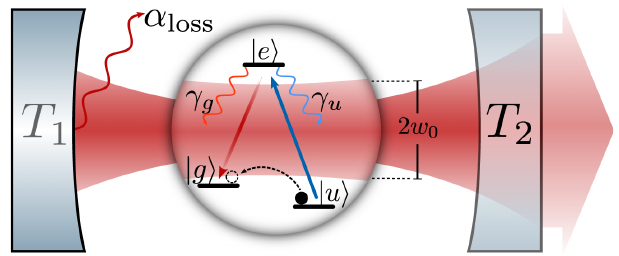
FIG. 1. Limits to photon collection: a quantum emitter in a cavity. A three-level emitter in the waist w 0 of a vacuum mode of a cavity formed by two mirrors with transmission values T 1 and T 2 . The unwanted cavity loss per round trip α loss includes T 1 . The | u (cid:2) ↔ | e (cid:2) transition is driven by an external field (blue arrow). The | g (cid:2) ↔ | e (cid:2) transition is coupled to the cavity (red arrow). For the generation of photons, the system is initialized into the state | u , 0 (cid:2) , where | 0 (cid:2) is the vacuum Fock state of the cavity. Emission of a photon into the cavity leaves the system in | g , 1 (cid:2) . Spontaneous decay from | e (cid:2) to | g (cid:2) with decay constant | e (cid:2) to | u (cid:2) with γ g ends the attempt in failure, whereas decay from decay constant γ u allows for subsequent cavity photon generation (re-excitation processes). The maximum probability for a cavity photon to be emitted into the cavity and transmitted to the free- space output mode to the right of the cavity is given by Eq.